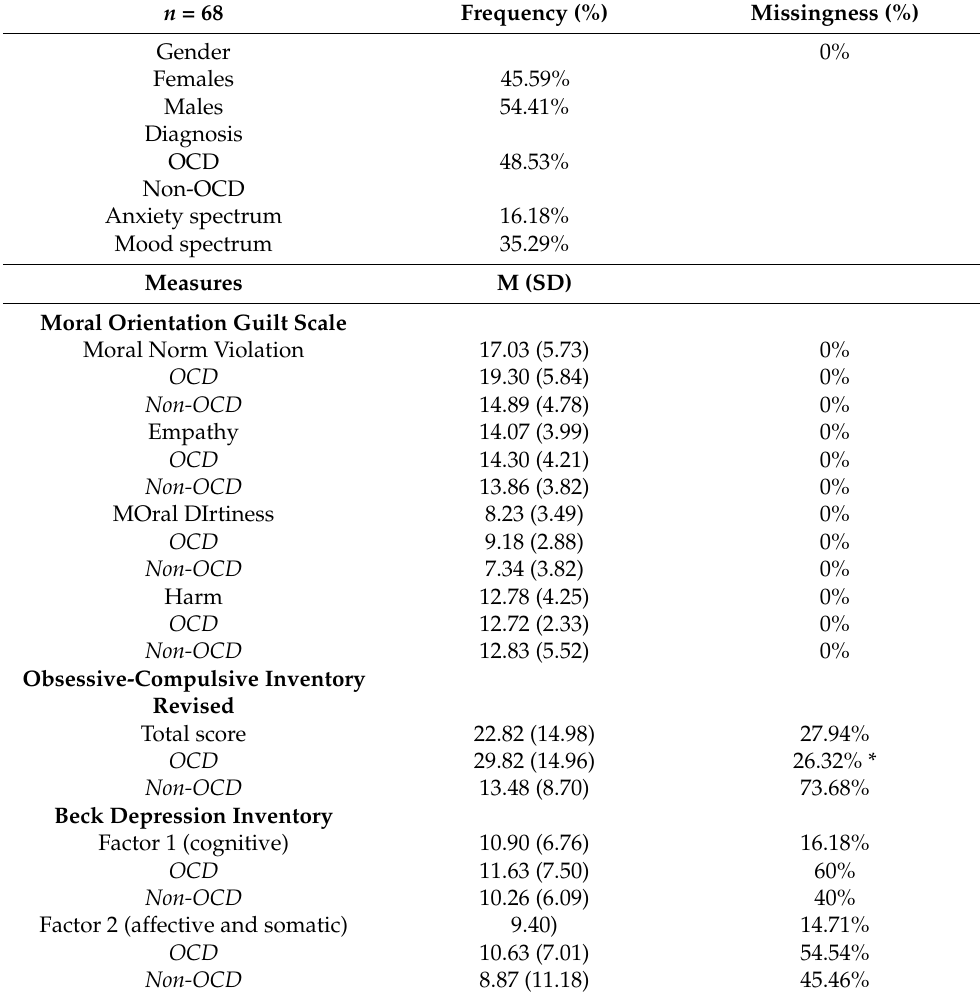
Table 1. Descriptives of the used sample. * Note that the percentages of each subsample are estimated starting from the percentage of missingness on the entire sample. n =